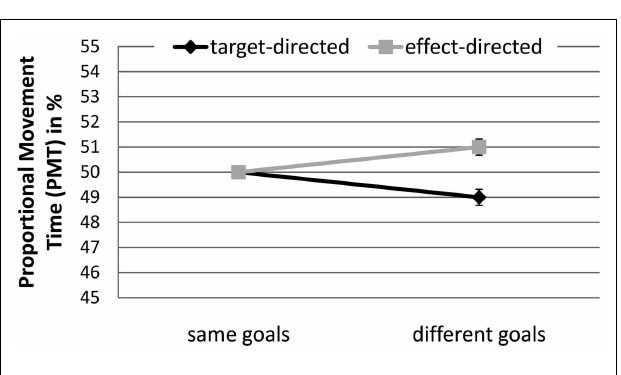
FIGURE 6 | Experiment 2: means and confidence intervals of Proportional MovementTime in % (PMT).